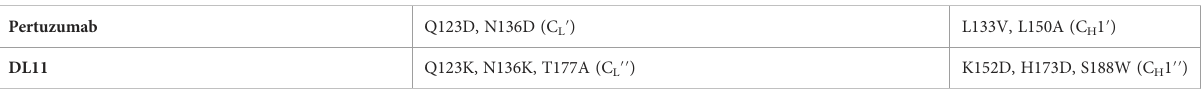
TABLE 1 C H 1-C L mutations that favor the formation of cognate heavy-light pairing over mispairing. The C H 1-C L of pertuzumab and DL11 are referred as C H 1 ′ -C L ′ and C H 1 ′′ -C L ′′ ,